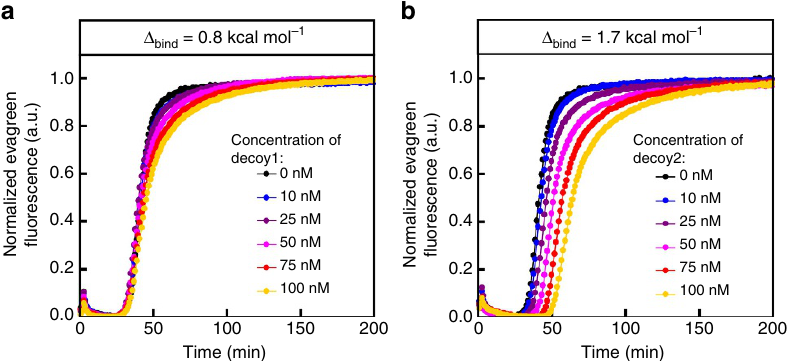
Figure 9 | Effect of a simple decoy on a simple autocatalytic loop. Autocatalytic amplification of template a to a 3 self-triggers within one hour and is marginally affected by the addition of decoy inhibitors decoy1 ( a ) or decoy2 ( b ), even when the decoy is a better binder and is twice more concentrated than the amount of autocatalytic template used (100nM).